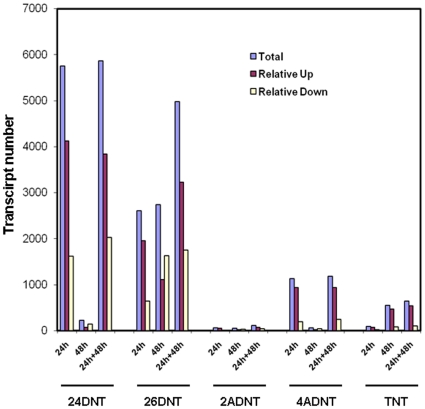
Total transcript numbers regulated by the five compounds.Rats were treated with different compounds with variant doses and microarray experiments were performed as described in Materials and Methods. The number of transcripts that were at each time point was analyzed using One-Way ANOVA with a Benjamin-Hochberg false discovery rate less than 0.05 across various doses at each time point (24 h or 48 h) for each compound. The total regulated transcript number for each compound was calculated by summarizing the numbers of both time points (24 h+48 h), and overlapped transcripts were only counted once. The relative up or down-regulated transcripts were obtained by comparing averaged animal samples with various dose treatments with respective control animal samples at each time point or both time points.